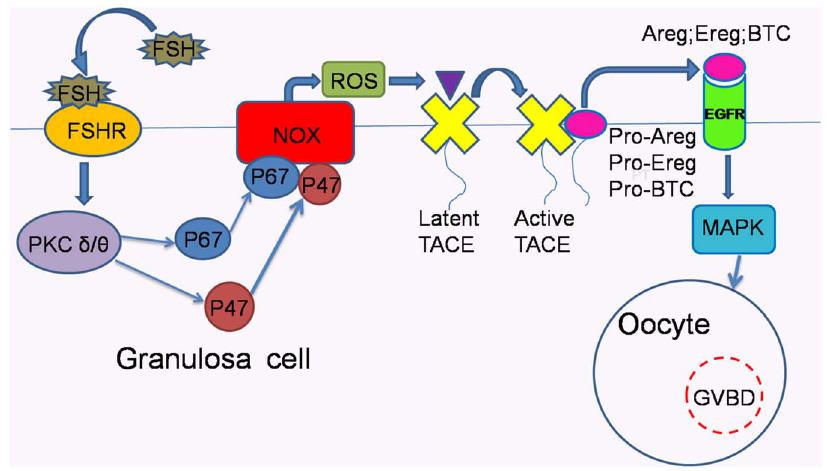
Figure 4. Possible signaling pathways that mediate FSH-induced meiotic resumption in COCs invitro . FSH acts through the downstream mediators PKC d and h , which recruit the cytosolic components p47 phox and p67 phox to the plasma membrane, allowing their combination with membrane components of NOX to form an active enzyme system to generate ROS. Then, ROS activate TACE by oxidizing the inhibitory prodomain to expose the catalytic domain. Next, the activated TACE via ROS cleaves pro-EGF-like factors into soluble EGFR ligands, which bind to and activate EGFR in an autocrine mode, thereby resulting in oocyte maturation.